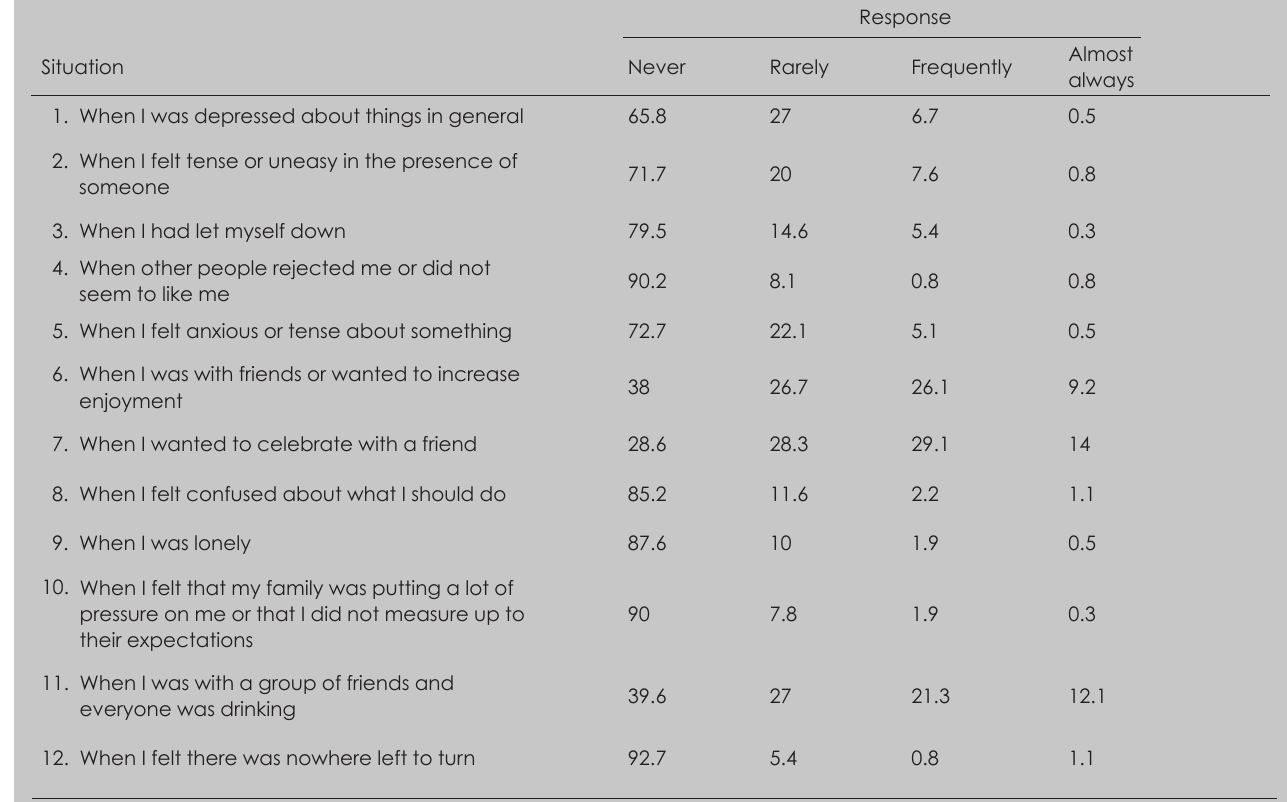
Table V. Inventory of alcohol- and drug-taking situations (%)